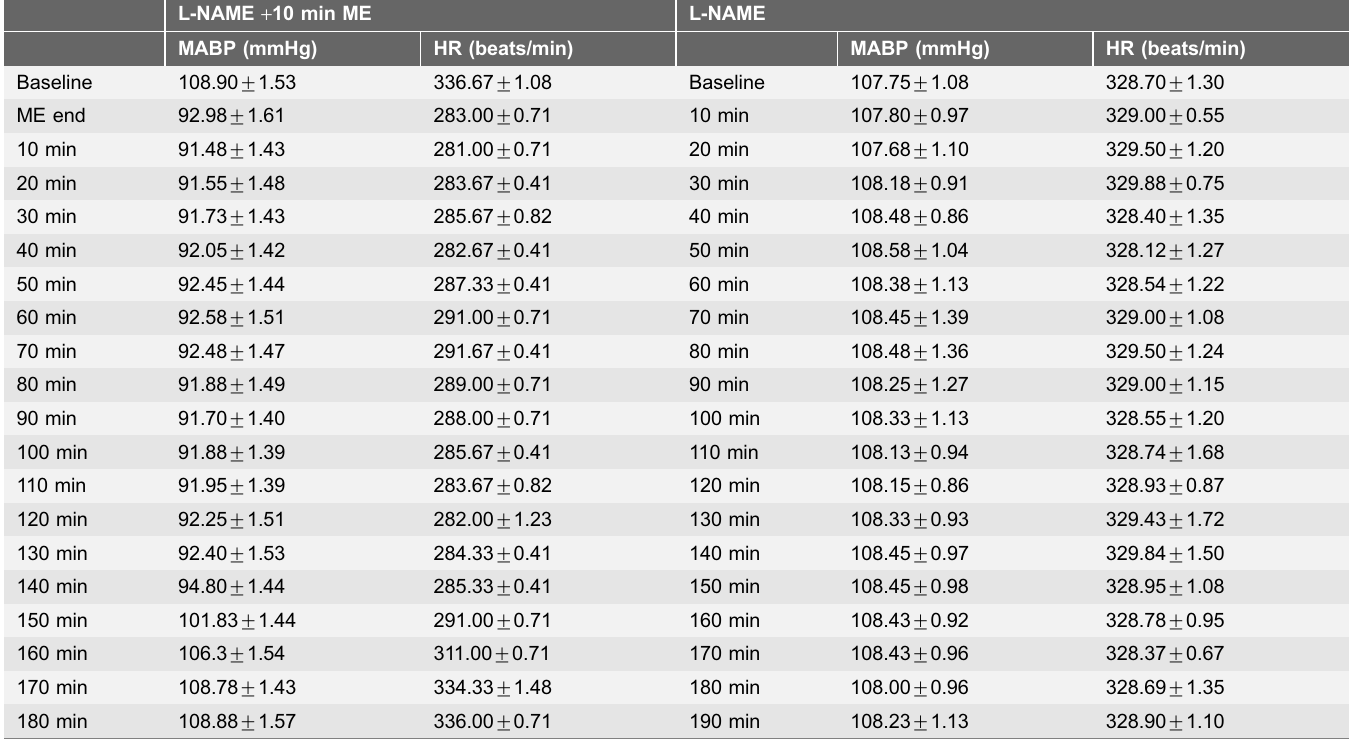
Table 4. Effects of i.v. administration of L-NAME on MABP and